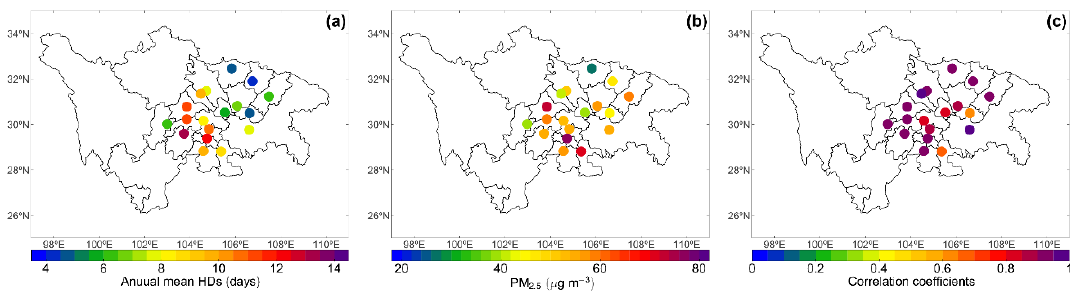
Figure 2. Validation of haze days (HDs) against PM 2.5 concentration at the 18 main cities of SCB in 2016. ( a – c ) The spatial distribution of annual HDs, distribution of annual mean PM 2.5 concentration collocating with the nearest observation stations, and the correlation coefficients between monthly HDs and monthly mean PM 2.5 concentration.